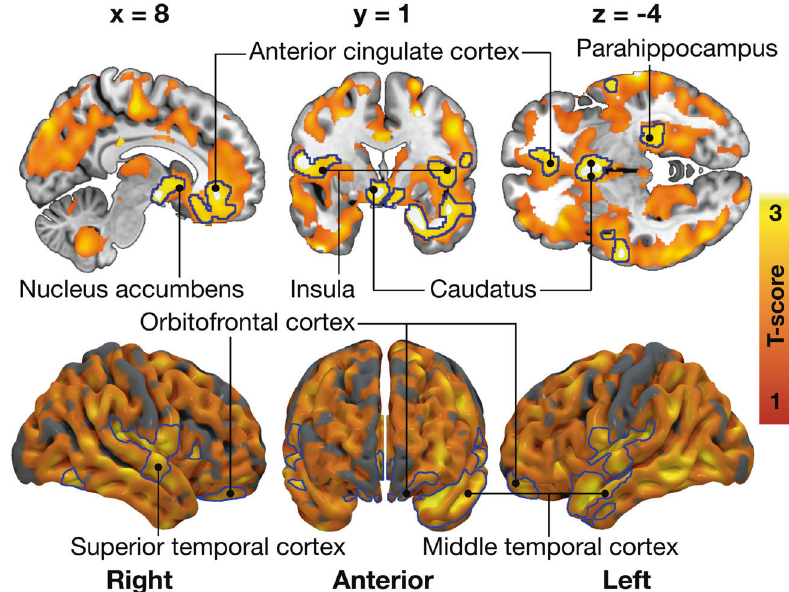
Fig. 4 Total Dutch Eating Behavior Questionnaire (DEBQ) score associated with decreased CB 1 receptor availability in the 35 males scanned with [ 18 F]FMPEP- d 2 . The blue outline marks brain regions where lower [ 18 F]FMPEP- d 2 volume of distribution ( V T ) associated with higher Total DEBQ score, age as a nuisance covariate, cluster forming threshold p < 0.01, FWE corrected. In the red – yellow T-score scale shown are also additional associations signi fi cant with more lenient cluster-de fi ning threshold ( p < 0.05, FWE corrected) for visualization